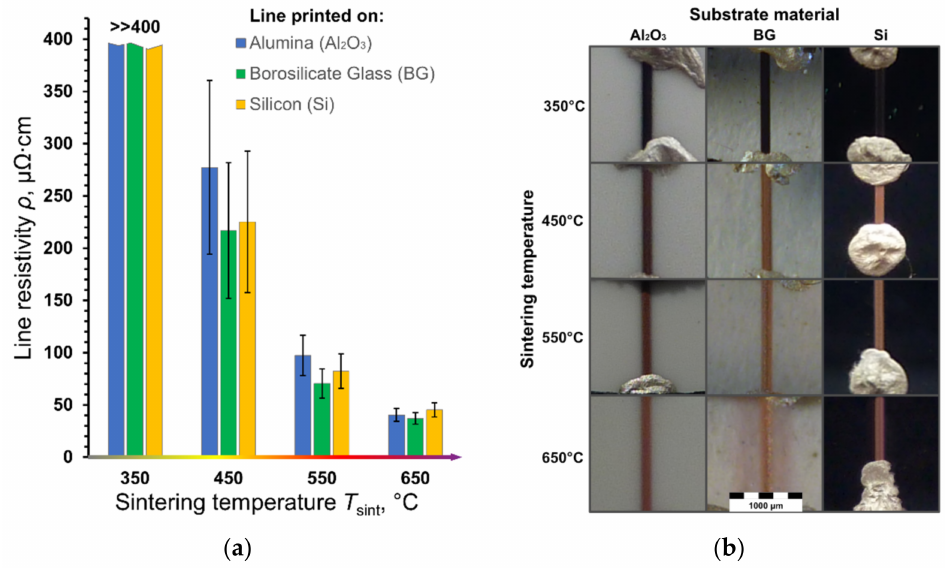
Figure 4. ( a ) Values of electrical resistivity and ( b ) corresponding optical images of printed lines on substrates of Al 2 O 3 , BG, and Si, depending on the reduction sintering temperature of 350–650 ◦